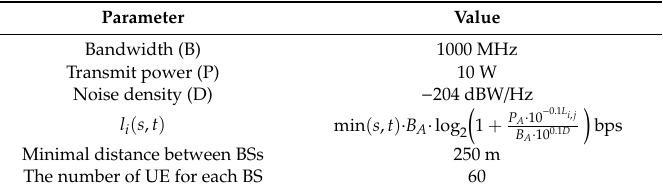
Table 1. Simulation parameters.